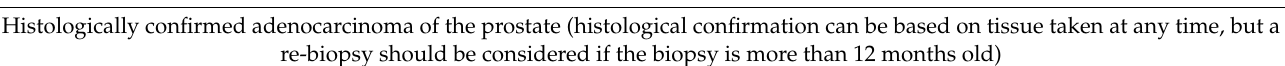
Table 1. Eligibility Criteria. Inclusion